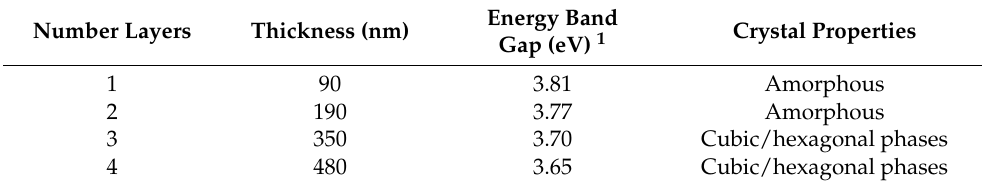
Figure 2. Zn(O;OH)S thin-film thickness as a function of CBD deposition time. White squares represent data and the red line represents the linear fitting. Fitting data: R 2 = 0.993. Fitting equation: y = 3.38( x ) − 18.5. Table 1. Optical and structural properties of the thin films, varying the number of layers deposited by CBD.